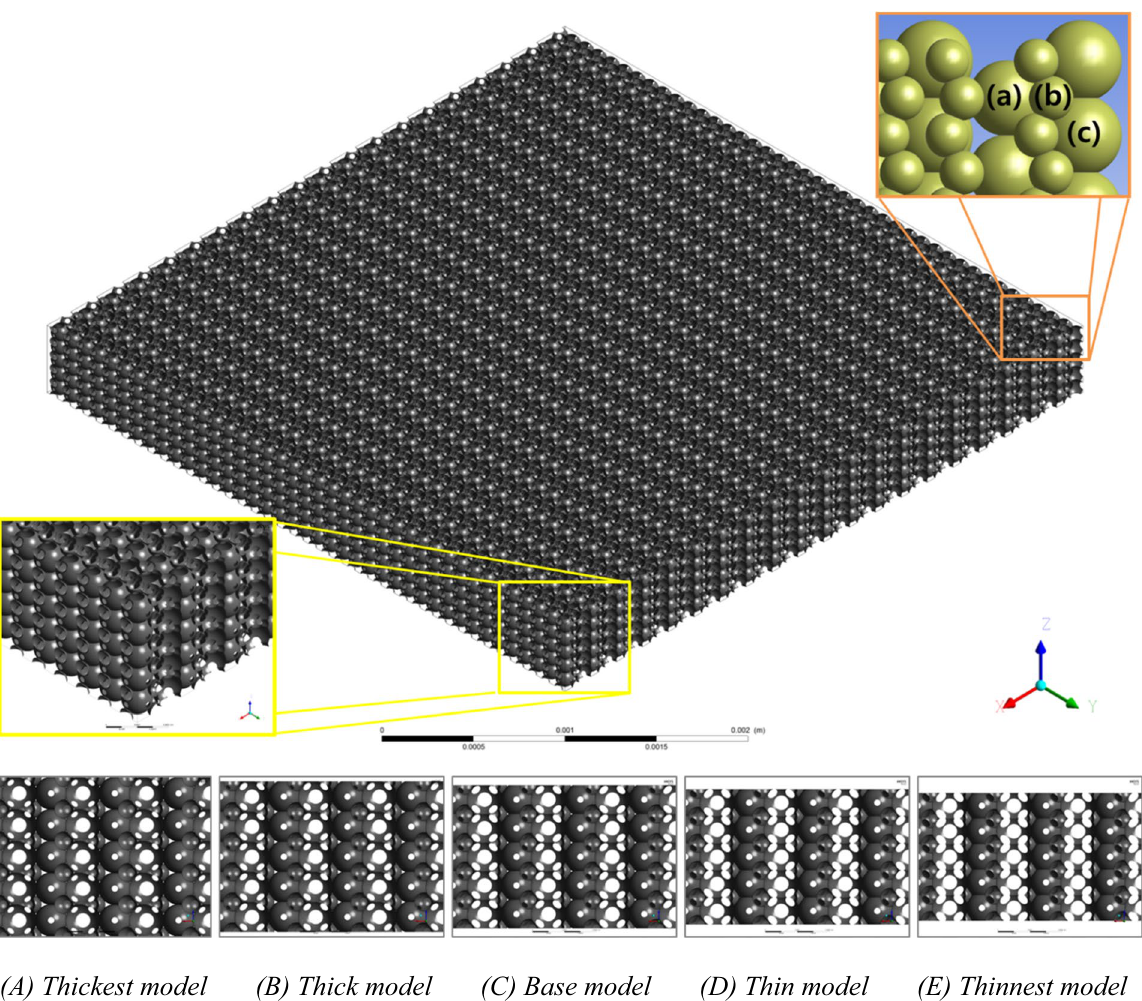
Figure 8. Original geometry of the multi-size pack model (upper figure, (C) base model) after five layers of three differently sized microbeads (a total of 28,160 microbeads) are excluded, along with the five